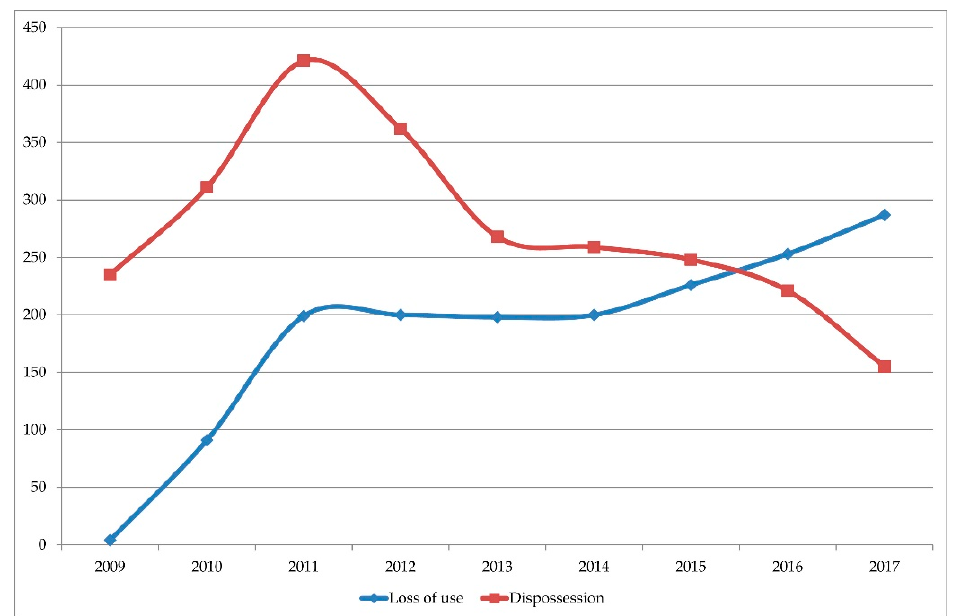
Figure 4. Number of Positive Judicial Actions of the Common Service of Las Palmas de Gran Canaria by type of procedure and year. Data: Common Service of Notifications and Liens of the Judicial District for Las Palmas de Gran Canaria. Own production.